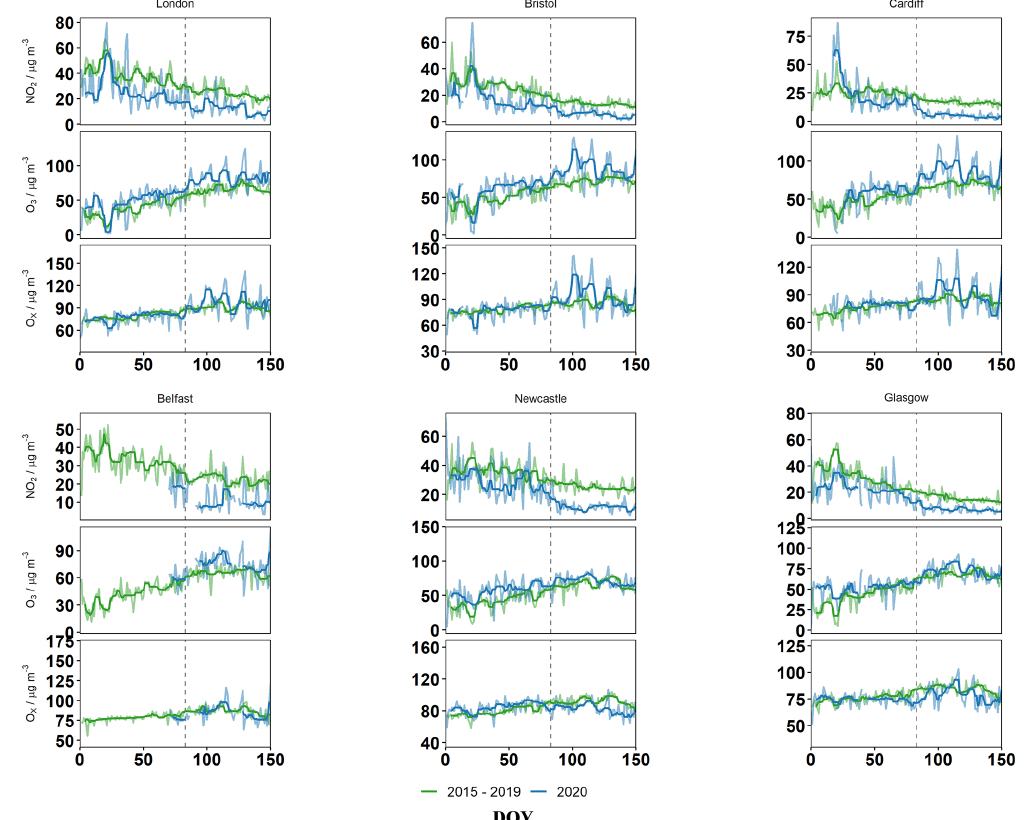
Figure 7. Daily median time series of NO 2 , O 3 and O x (NO 2 + O 3 ) for 2020 and the average of 2015–2019 at urban background sites in six cities representing a geographical and political spread across the UK. The thick line represents the 7d rolling mean. The dashed grey line indicates the start of the lockdown